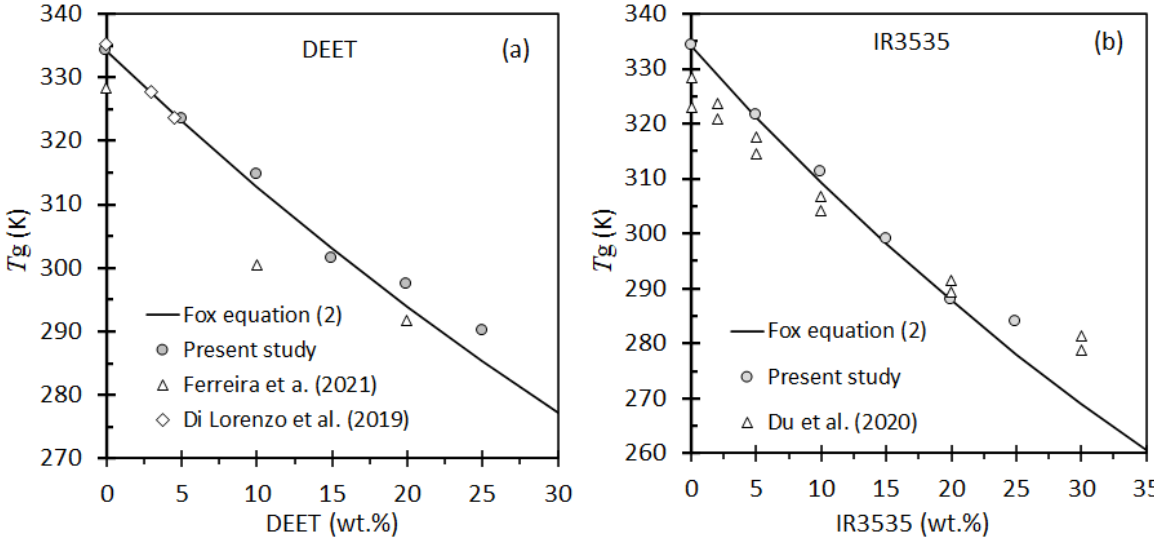
Figure 3. Experimental data for the glass transition temperatures for blends of PLA with ( a ) DEET and, ( b ) IR3535. The continuous line shows the trend, predicted by the Fox model, for the present data.